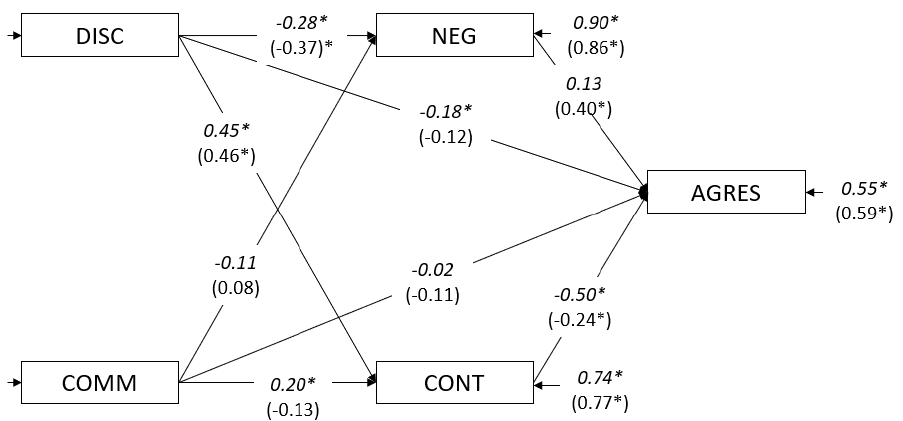
Figure 4. Mediational model for the 3–6-year-olds by gender. Note: DISC = discipline; COMM = communication; NEG = negative affect; CONT = effortful control; AGRES = aggressive behavior. Values in italics are for boys; values in parentheses are for girls. * p > 0.05.